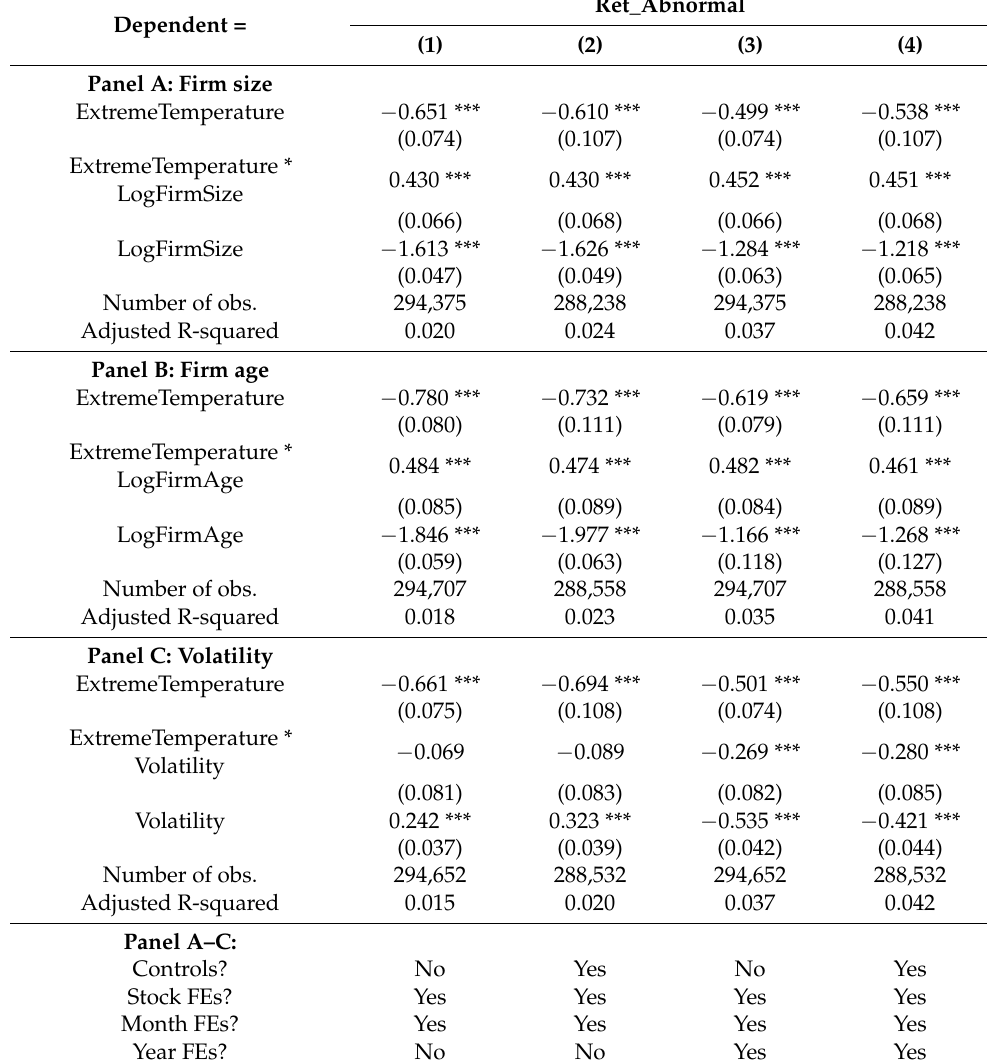
Table 4. The impact of extreme temperature across size and age